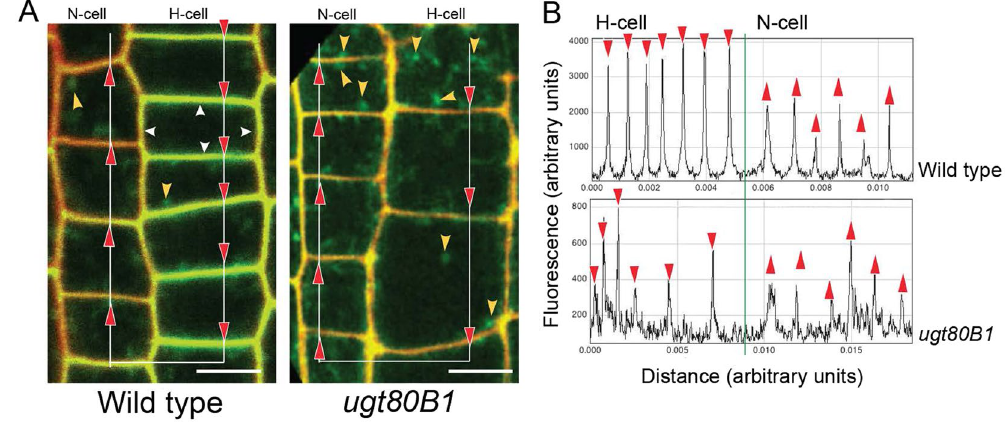
Figure 4. Aberrant subcellular localization of SCM:GFP in ugt80B1 epidermal cells from the elongation zone of the root. ( A ) Wild-type and ugt80B1 roots expressing proSCM:SC M:GFP were stained with propidium iodide (red) to distinguish cell walls from plasma membrane labeled with SCM:GFP (green). Two adjacent cell files from elongation zones are shown. Wild type exhibits clear cell periphery localization of SCM:GFP (white carats) in one of the two cell files, differentiating developing H cells from N cells. In ugt80B1 , a decrease in cell peripheral localization of SCM:GFP can be seen, and signal is detected in both H and N cell files indicating a loss in cell-type specific accumulation of SCM. An increase in cytoplasmic punctae labeled with SCM:GFP is visible in both cell files in ugt80B1 (yellow carats). (scale bar = 10 μ m) ( B ) Fluorescence intensity transect plots derived from SCM:GFP at the apical-basal plasma membrane juncture of H and N cells were measured in arbitrary fluorescence units for both wild-type and ugt80B1 (red carats in A and B ).